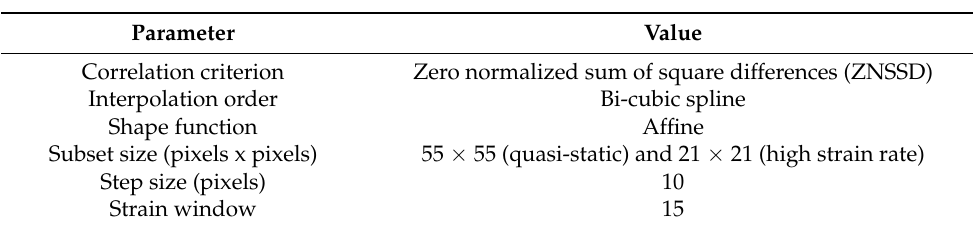
Table 2. Processing parameters for